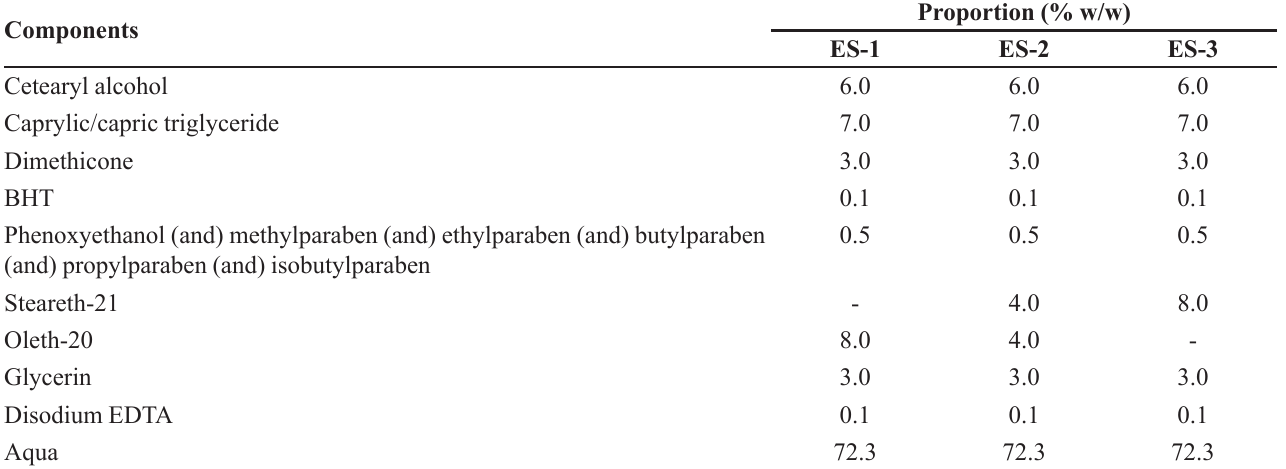
TABLE I - Emulsified systems composition (% w/w)